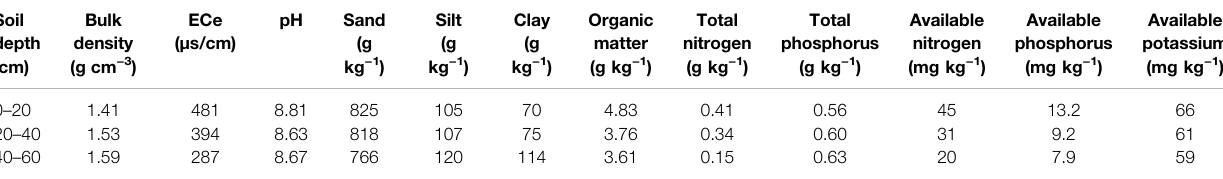
TABLE 1 | The basic properties of aeolian sandy soil in the experiment